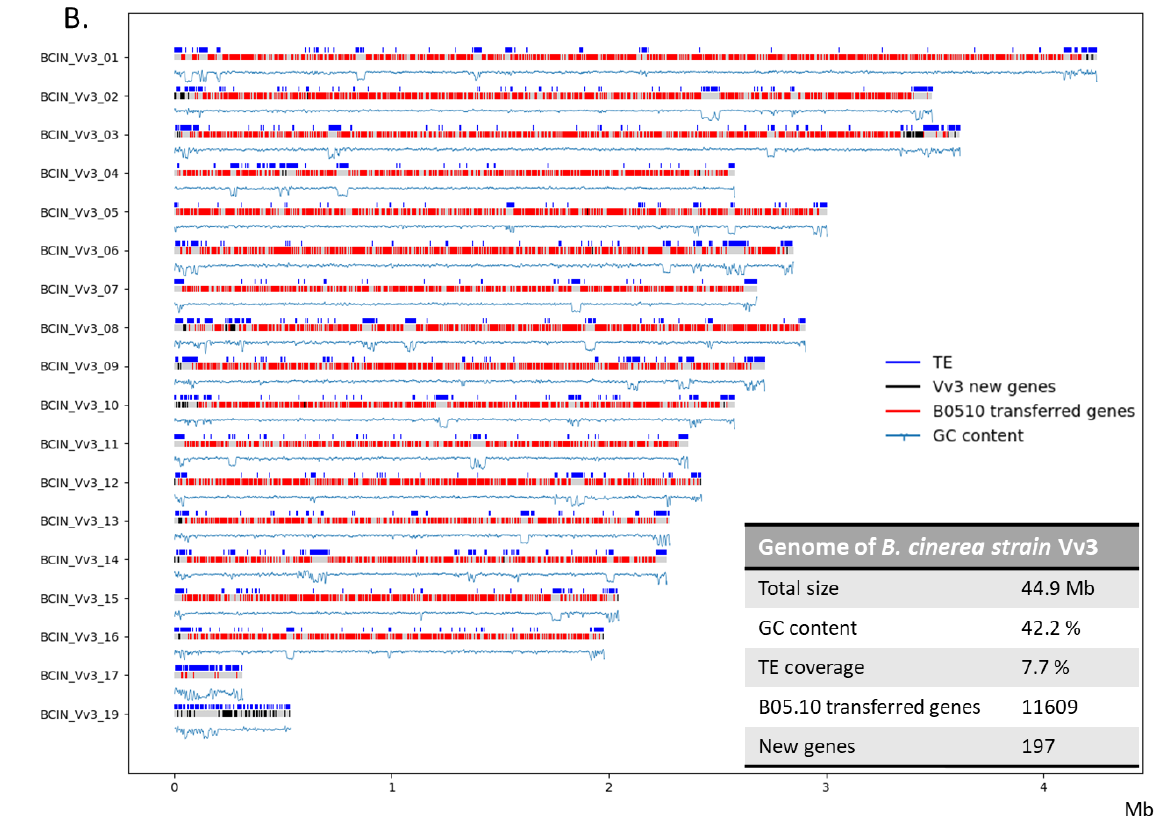
Figure 1: Genome organization in B. cinerea strains Sl3 (A) and Vv3 (B). The two karyoplots show chromosomes identified in each strain, genes previously predicted in the B05.10 reference strain (van Kan et al., 2017; red), newly detected genes (black), Transposable Elements (TEs; dark blue) and the GC content (blue) along the Core Chromosomes (CCs BCIN_01 to 16) and the Accessory Chromosomes (ACs BCIN_17 to